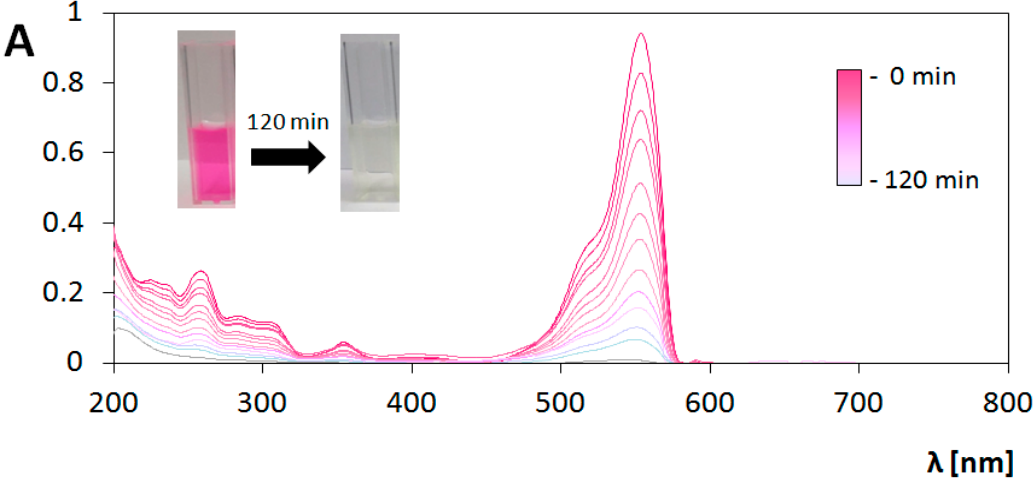
Figure 8. Changes in absorption spectrum of rhodamine B (RhB) solution during photocatalysis on bare TiO 2 coating under ultraviolet (UV) illumination. Insert: change in color of solution.